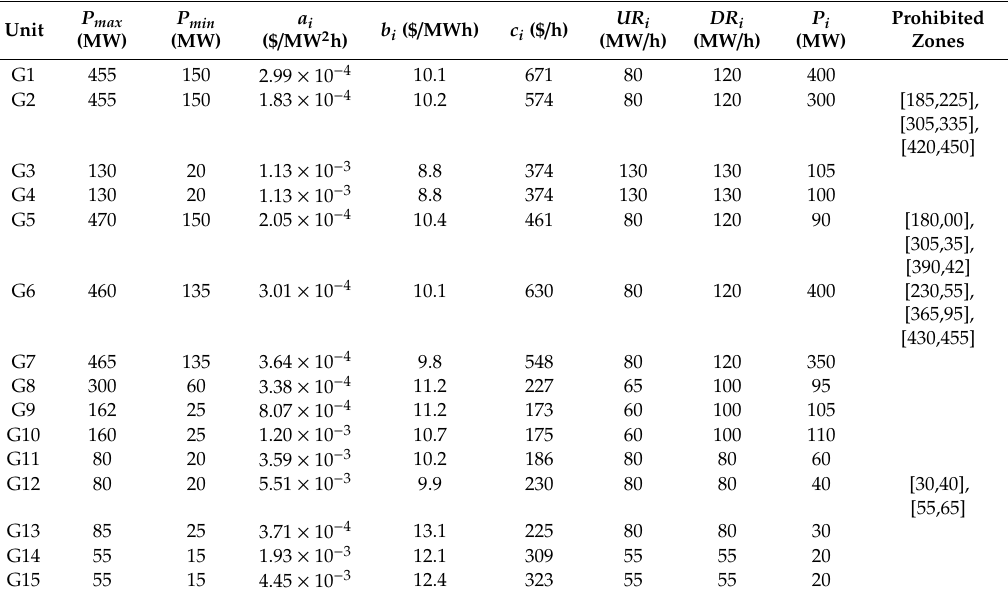
Table 7. The detailed generator unit data of System 2.